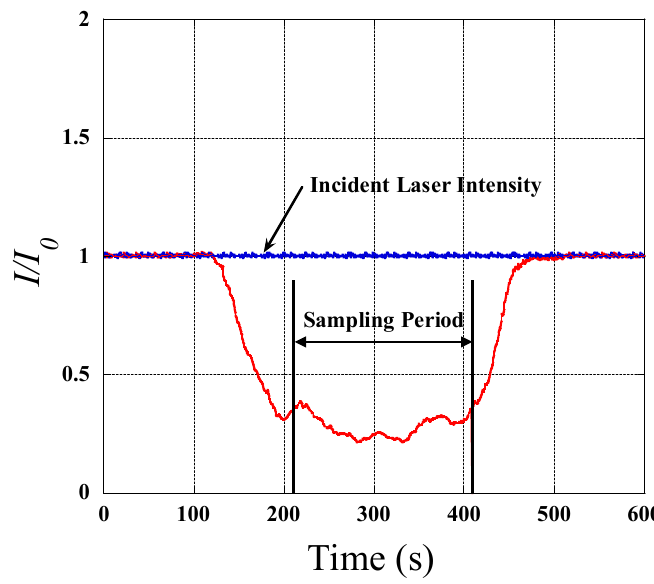
Figure 4. Light attenuation in TC measured as a function time.